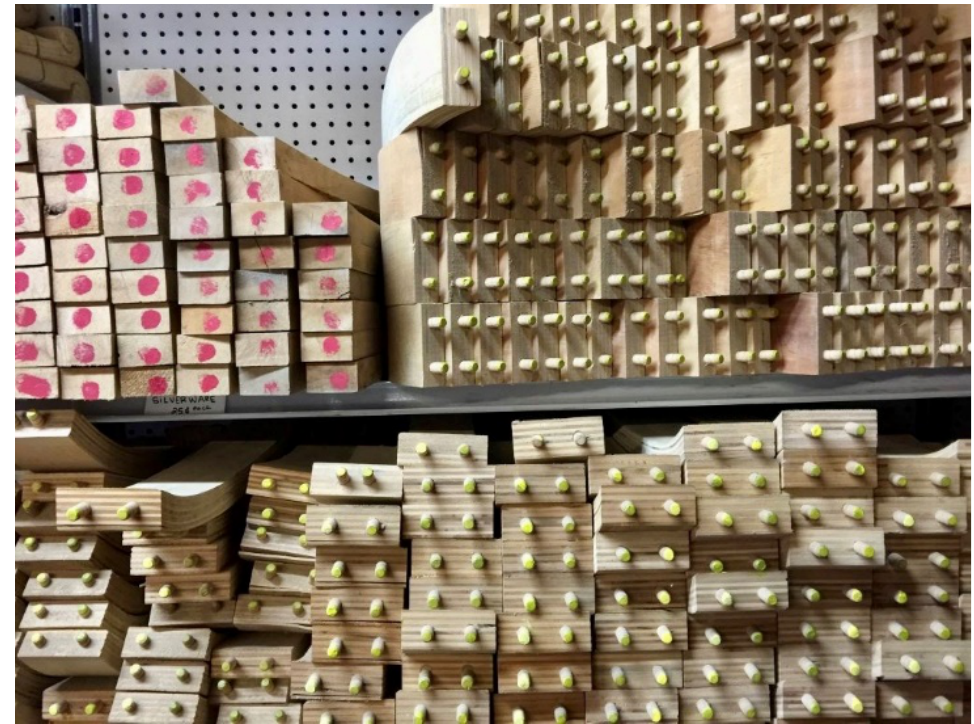
Figure 4. Indoor Shelf at The Repurpose Project, 2018.